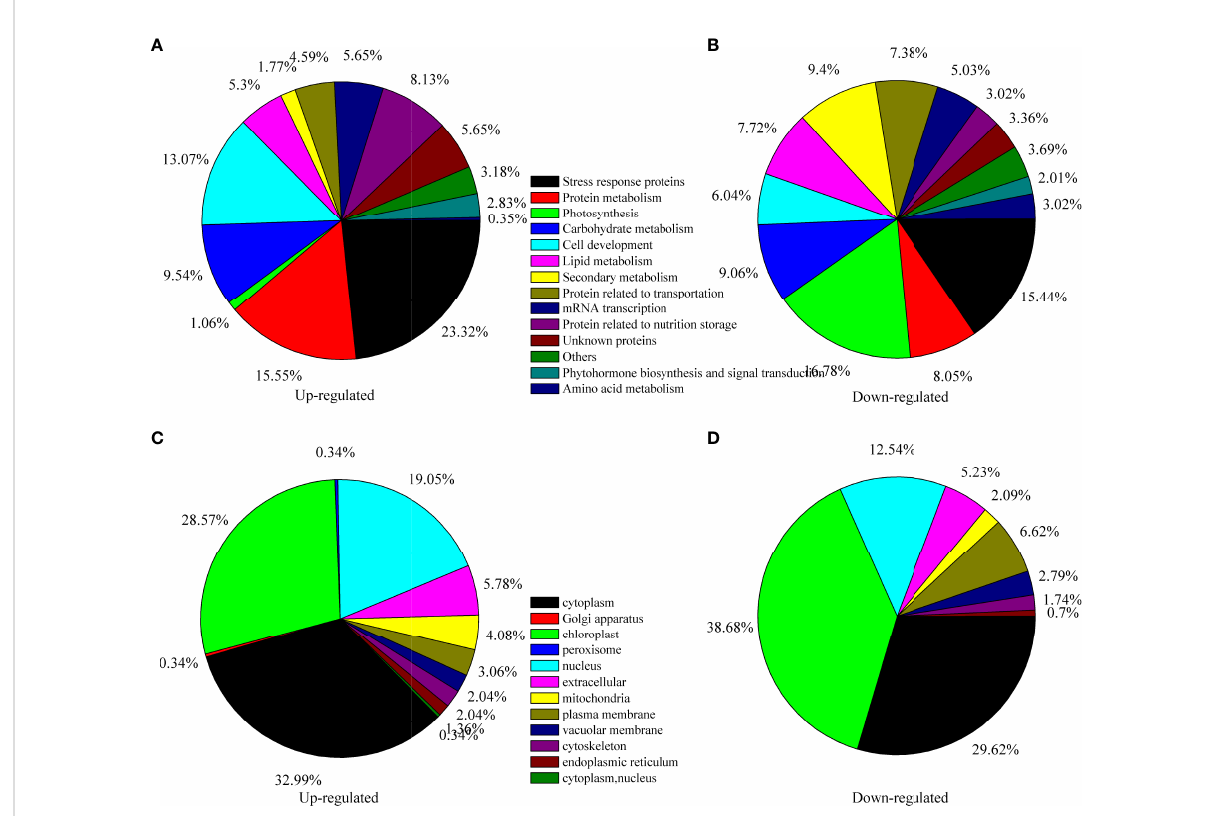
FIGURE 3 Functional classi fi cation and subcellular localization of all differentially accumulated proteins (DAPs) in quinoa seed from different developmental stages. (A) Function classi fi cation of upregulated DAPs, (B) function classi fi cation of downregulated DAPs, (C) subcellular localization of upregulated DAPs, and (D) subcellular localization of downregulated